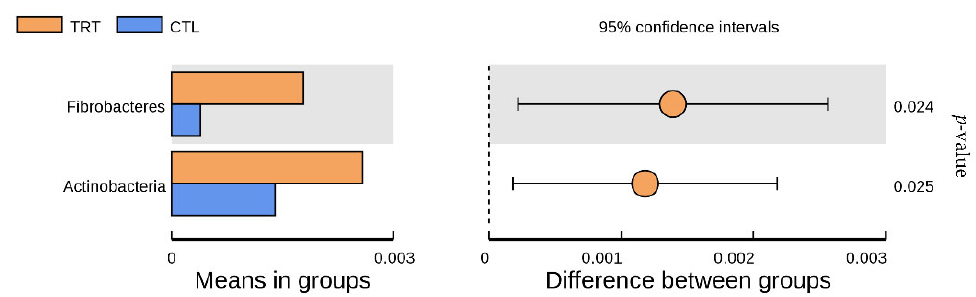
Figure 5. Analysis of distinct species between treatment groups at the phylum level. n = 10. CTL, sow fed the basal diet; TRT, sow fed basal diet with silymarin 40 g/d from late gestation to lactation. Table 3. The effect of dietary silymarin supplementation on the relative abundances of eight phyla (%, the relative abundance > 0.1%) in sow feces and Firmicutes/Bacteroidetes ratio.